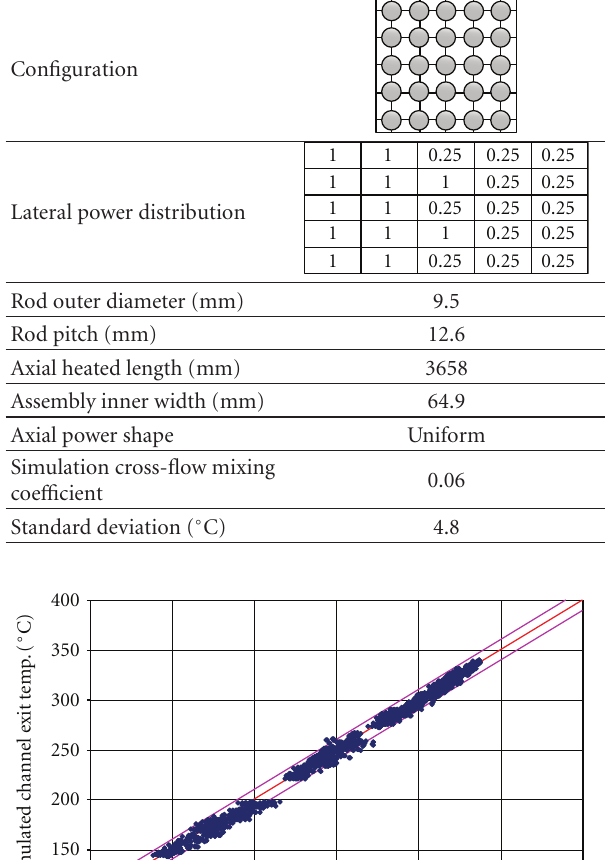
Table 4: Steady-state mixing experiment conditions.